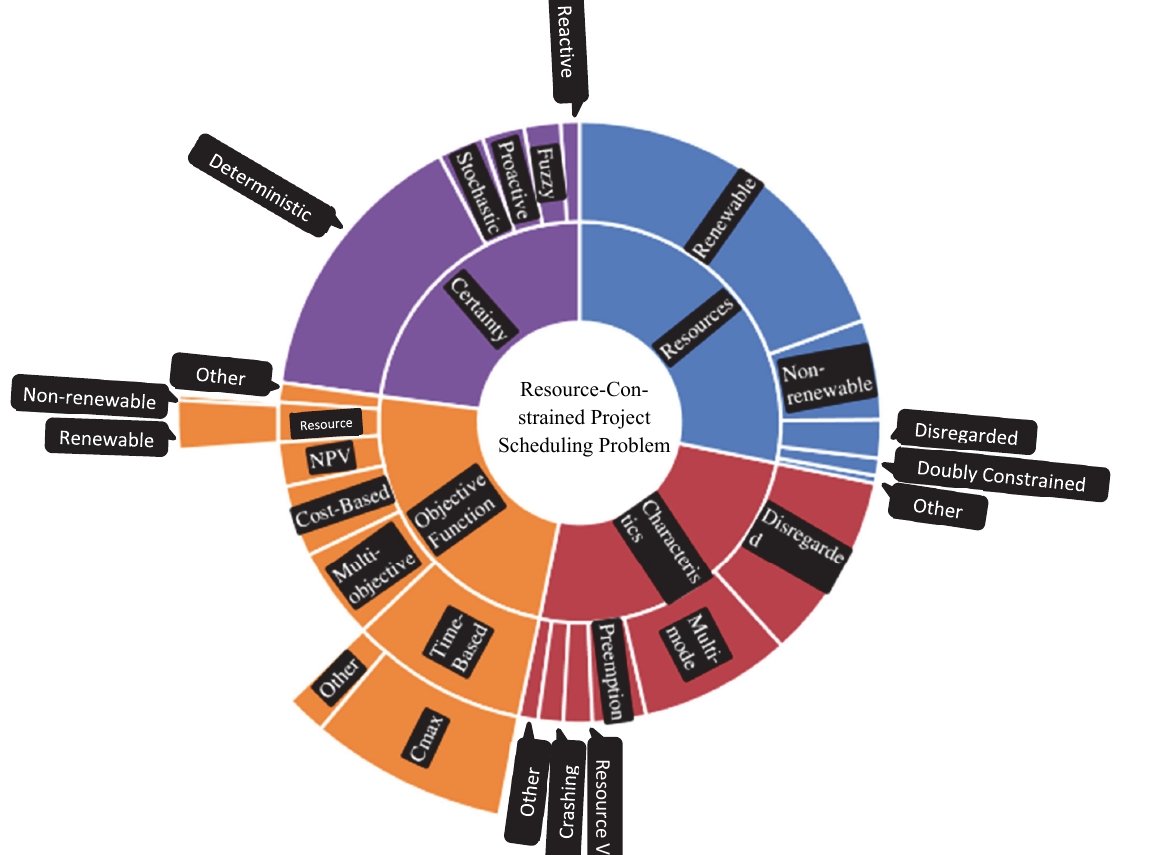
Fig. 3. Frequency of different RCPSP